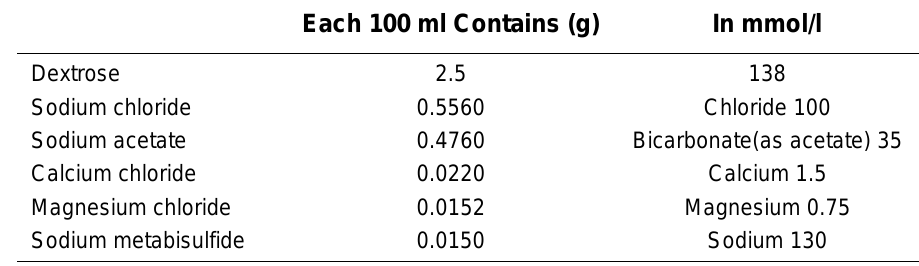
Composition of Dialysis